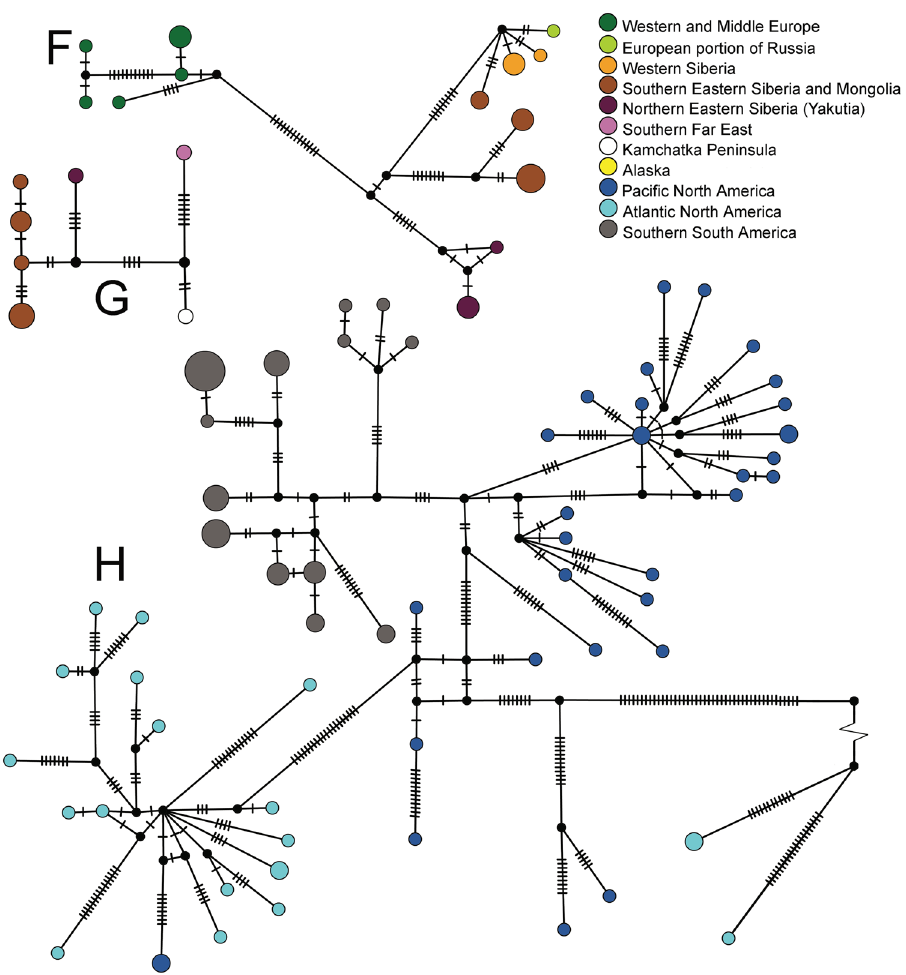
Figure 4. Median-joining haplotype networks of mitochondrial clades for neustonic daphniids in the Scapholeberis rammneri group. Bold letters indicate geographic clade names provided in Fig. 2. Pie diameter indicates the frequency of the haplotype and substitutions among haplotypes are depicted by hash